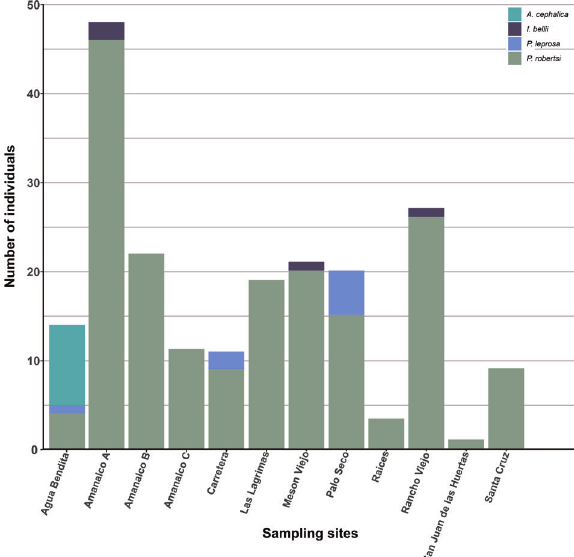
Figure 2. Number of individuals per species in each sampling site.